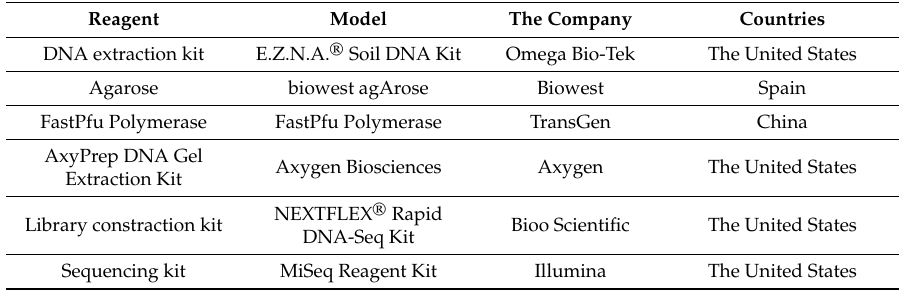
Table 4. Experimental materials and reagents.